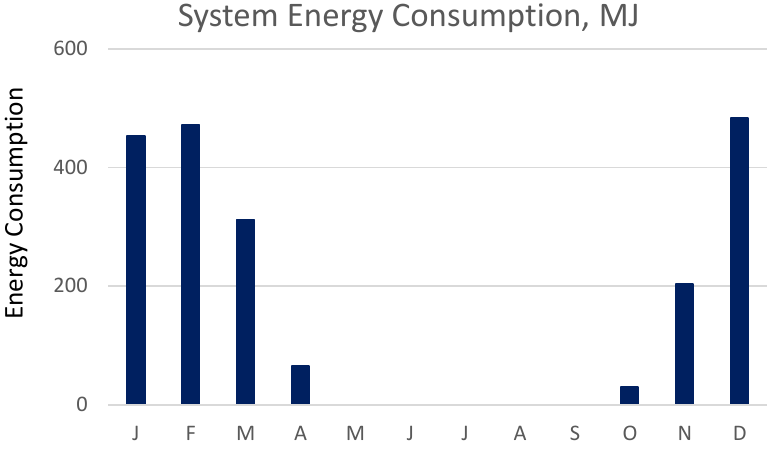
Figure 11. Electrical-energy consumption of the cooling system.